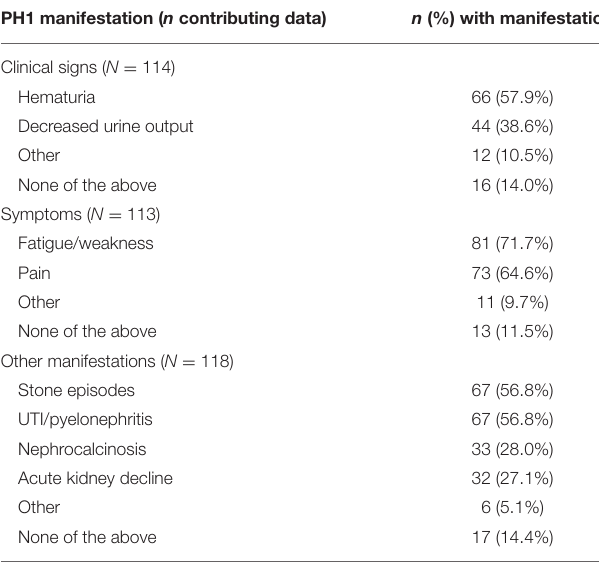
TABLE 2 | Prevalence of clinical signs, symptoms, and other PH1 manifestations during Value